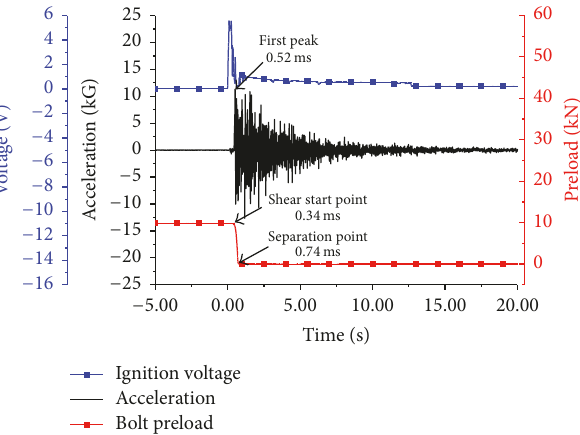
Figure 6: Measurement output time history of explosive bolts.